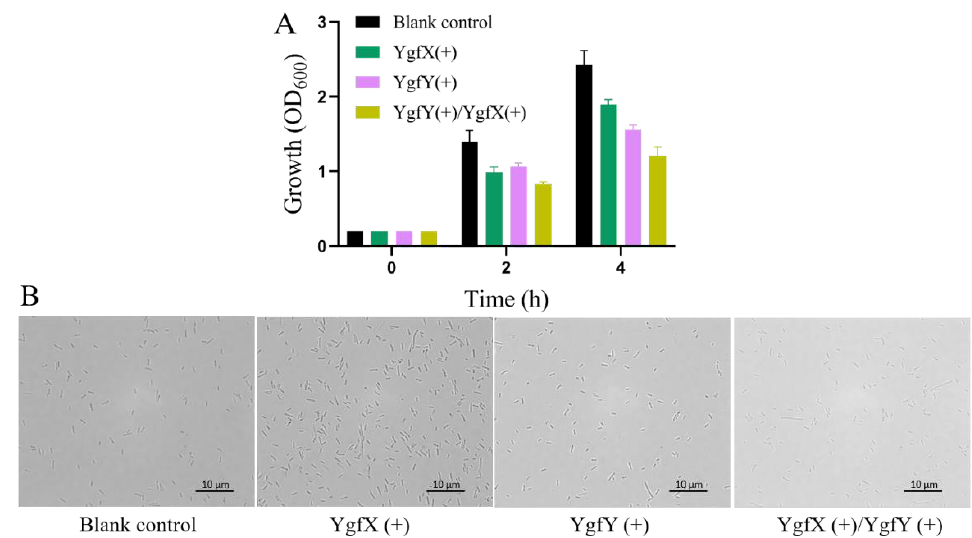
Figure 3. Hetero-expression of YgfY in E. coli BL21(DE3). ( A ) Growth of E. coli BL21(DE3) expressing YgfY and/or YgfX under induction. Cultures of E. coli BL21 bearing pBAD24_ ygfX and pET_ ygfY were grown to early exponential phase before the addition of inducers or glucose. The data are the mean ± SD ( n = 3). ( B ) Cell morphology observed after induction for 4 h.